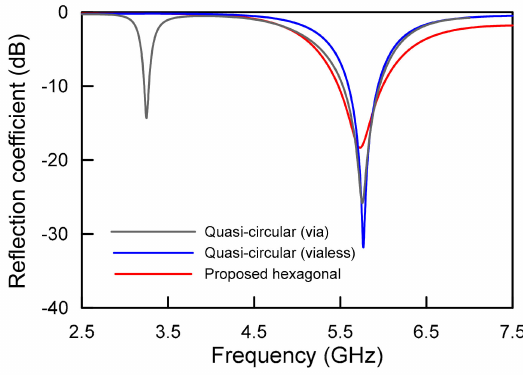
Figure 3. Reflection coe ffi cient comparison of the three kinds of antenna design in Figure 2.